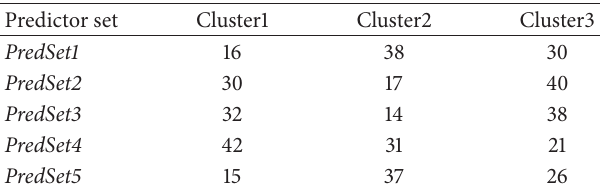
Table 4: Cluster size (number of years) by fuzzy 𝑐 -means clustering with 𝛼 -cut of 0.3 over the period